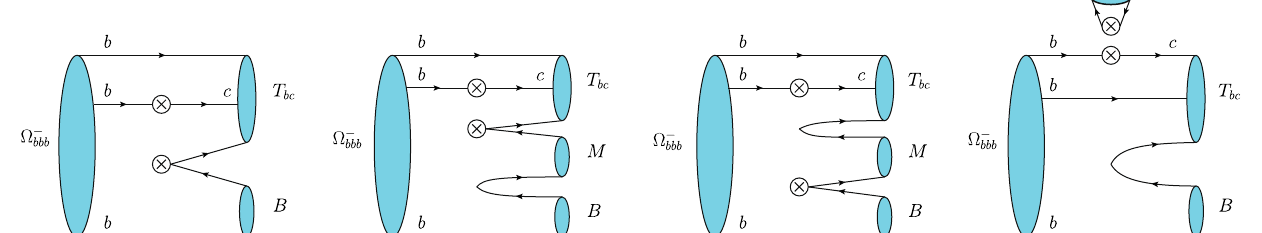
Fig. 4 Feynman diagrams for (cid:2) − decays into a doubly heavy baryon T bc , plus a B -meson and a light meson bbb